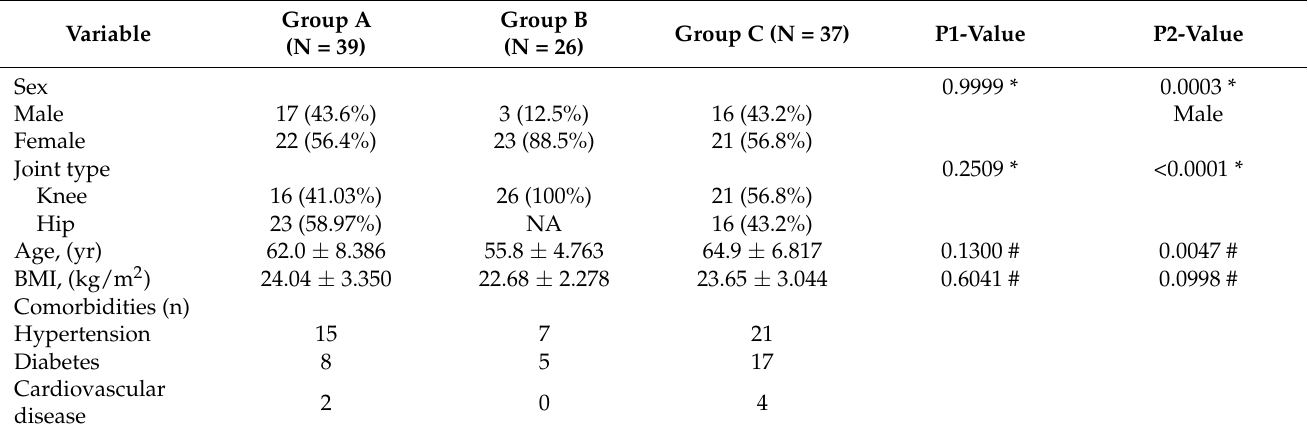
Table 1. Demographic data for the study population.